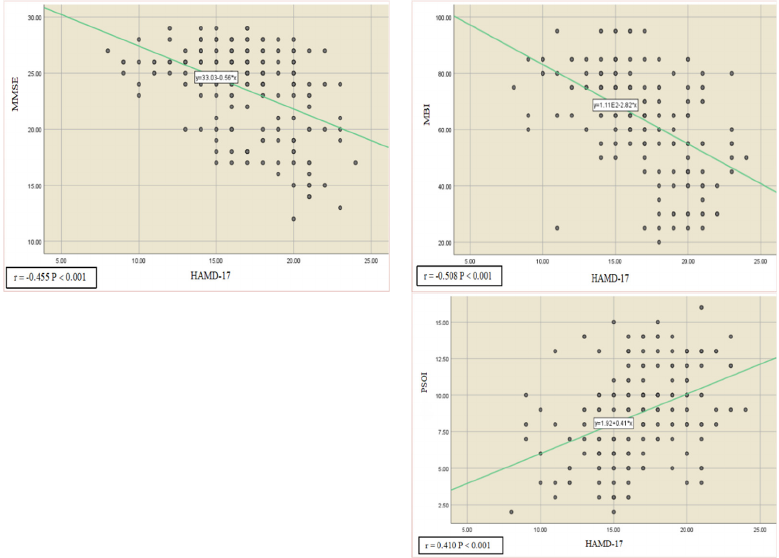
Figure 2. Pearson’s correlation analysis was used to consider all subject in T 0 , T 1 , T 2 between MMSE, MBI, PSQI, and HAMD−17 scores, showing a strong negative correlation between HAMD−17 and MMSE (r = −0.455, p < 0.001), a positive correlation between HAMD−17 and PSQI (r = 0.410, p < 0.001), and a negative correlation between HAMD−17 and MBI (r = −0.508, p < 0.001). The lower PSQI score and the higher MMSE and MBI score, the lower HAMD−17 score, corresponding to a better psychological state.